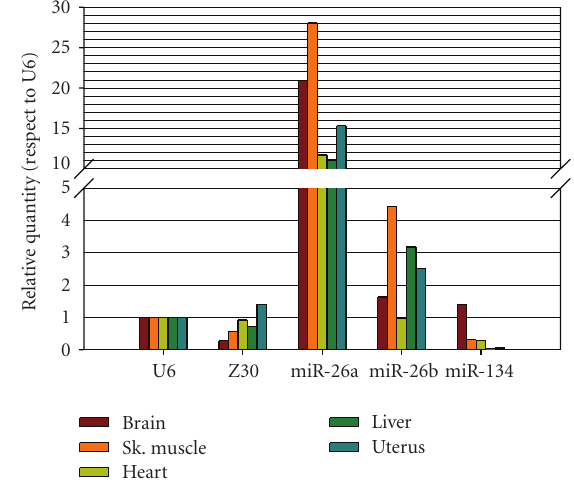
Figure 6: Corrected comparison of the relative expression of a miRNA selection in five di ff erent tissues (brain, skeletal muscle, heart, liver, and uterus) with respect to the U6 endogenous